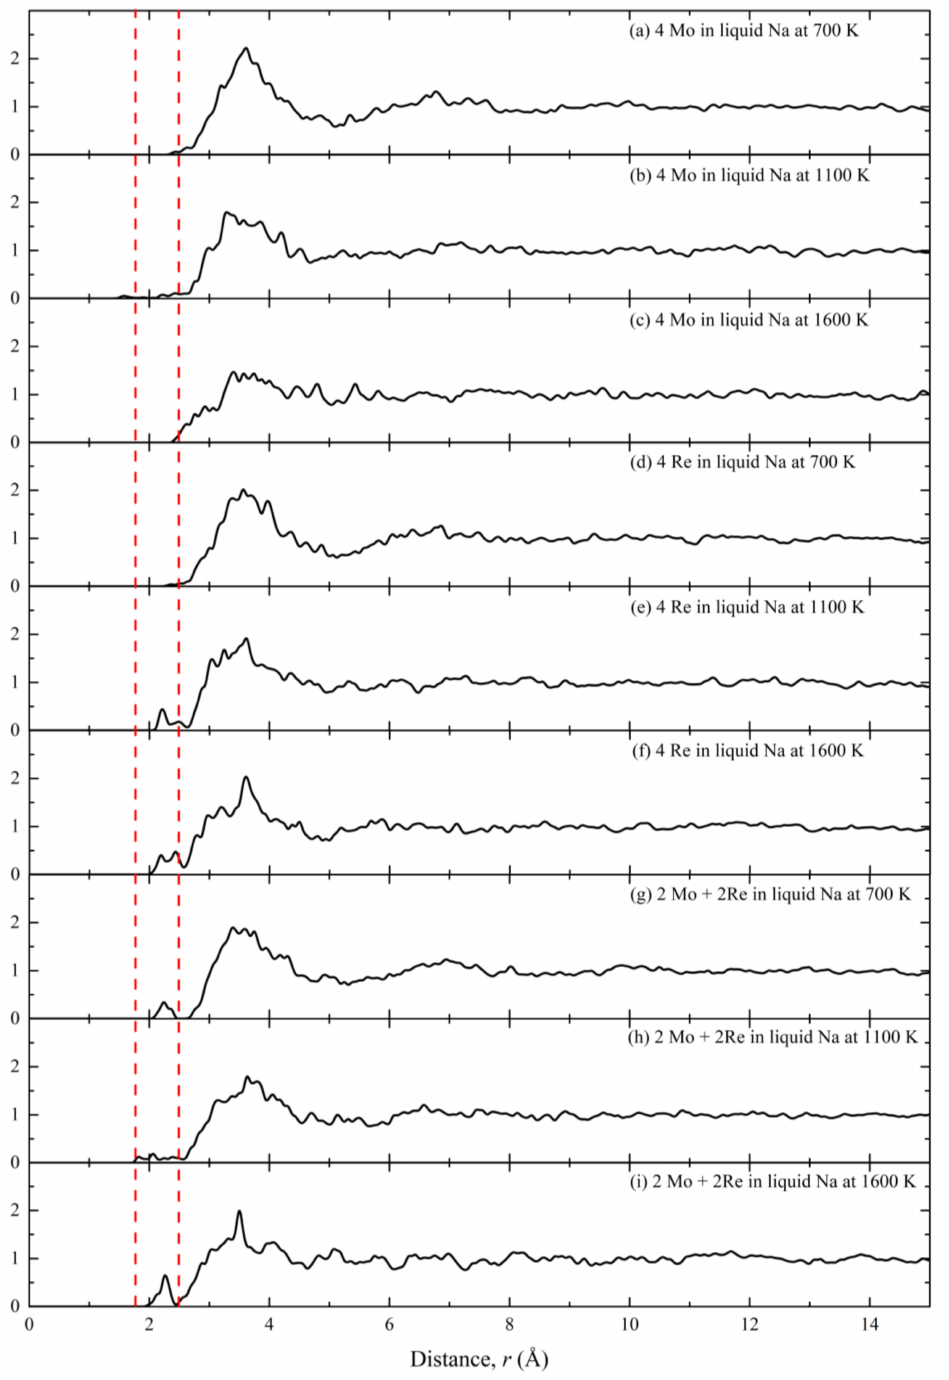
Figure 6. Total pair correlation function of four solute atoms in liquid Na at different systems: ( a – c ) four Mo atoms in liquid Na at 700 K, 1100 K and 1600 K, respectively; ( d – f ) four Re atoms in liquid at different temperatures; ( g – i ) two Mo atoms and two Re atoms in liquid Na at different